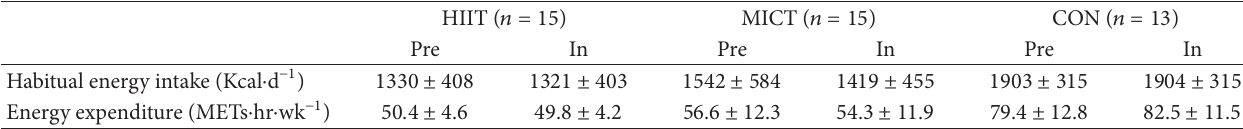
Table 2: The habitual energy intake and expenditure (excluding training) during the 3-week preintervention (Pre) and 12-week intervention (In) periods in HIIT, MICT, and CON